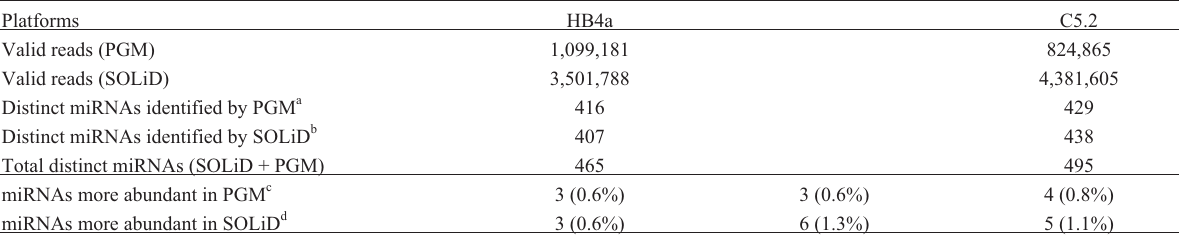
Table 1 - Sequencing results and miRNA identification in cell lines for NGS